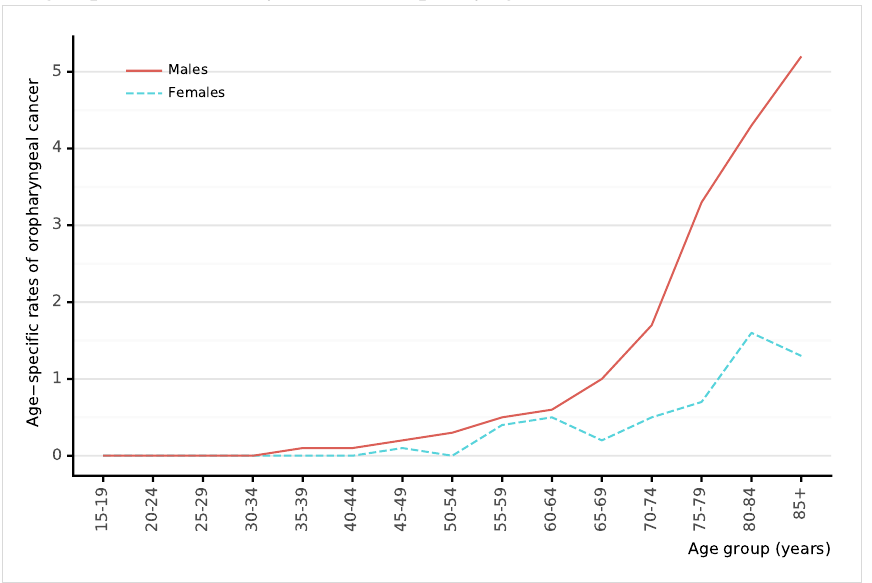
Figure 38: Age-specific mortality rates of oropharyngeal cancer in Peru (estimates for 2020)